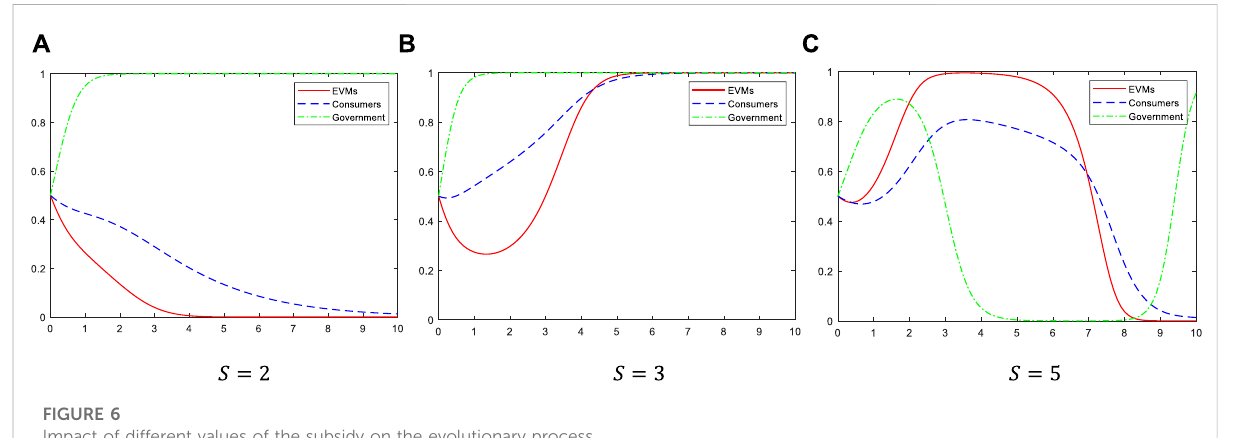
FIGURE 6 Impact of different values of the subsidy on the evolutionary